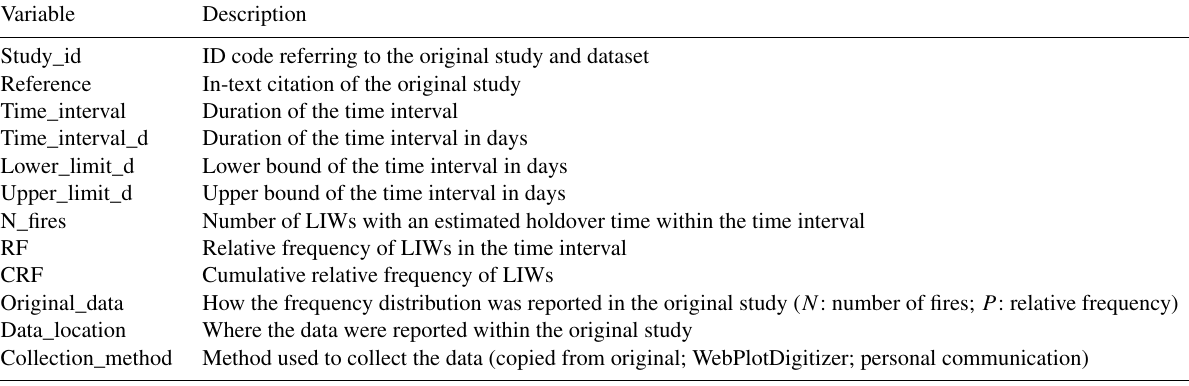
Table 1. Overview of the variables of censored data from the database on holdover time of LIWs.